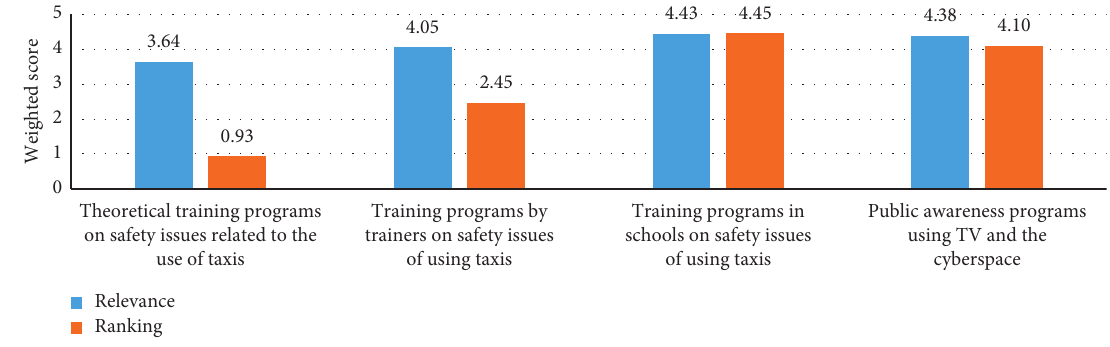
Figure 12: Weighted mean of relevance and priority ranking related to Question B4.